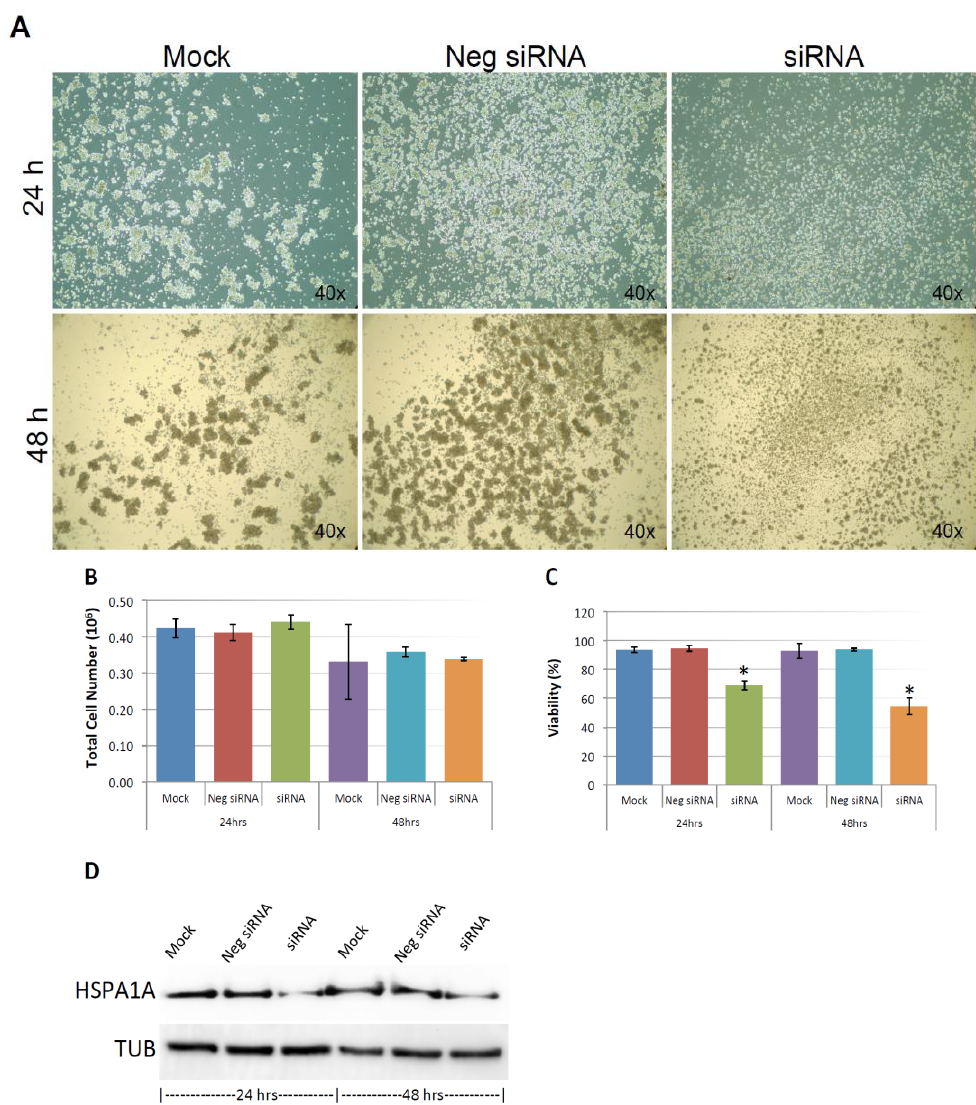
Figure 9. Knocking-down HSPA1A showed similar effect compared to silencing the expression of KIAA0100 in MDA-MB-231 cells. ( A ) MDA-MB-231 cells were transfected with HSPA1A siRNA, cell morphologies were observed under microscopy at 24 and 48 h after the treatment. Mock and negative siRNA treated cells show significant aggregation in suspension culture in 24 and 48 h, while HSPA1A siRNA treated cells lost cell aggregation from 24 h after the treatment; ( B ) total cell number in the suspension culture were similar at 24 and 48 h between mock, negative siRNA treated cells and the HSPA1A siRNA treated cells; ( C ) viability of the HSPA1A treated cell dropped to about 70% in 24 h and then below 60% in 48 h; ( D ) Silencing the expression of HSPA1A by the siRNA was confirmed by Western blot analysis.